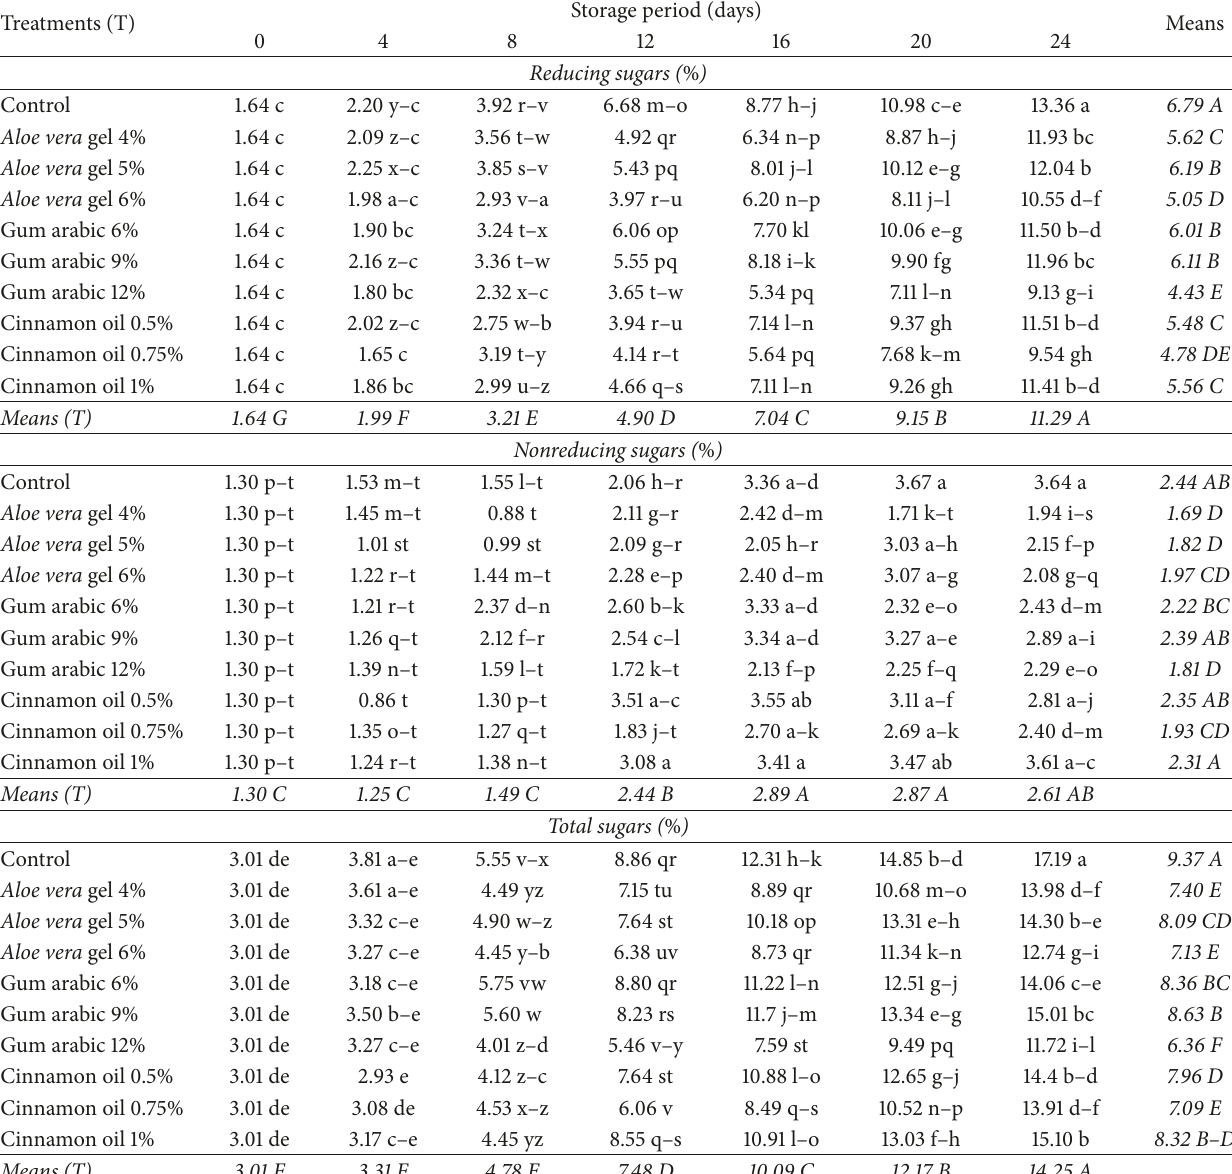
Table 2: Effect of Aloe vera gel, gum arabic, and cinnamon oil on reducing sugars (%), nonreducing sugars (%), and total sugars (%) of bell pepper during cold storage